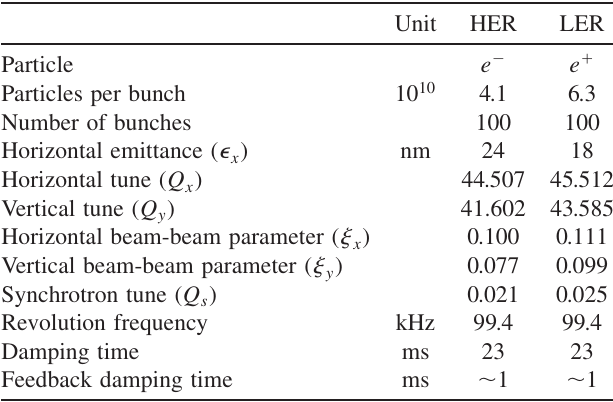
TABLE I. Machine parameters during the December 2008 crab-cavity experiments in the